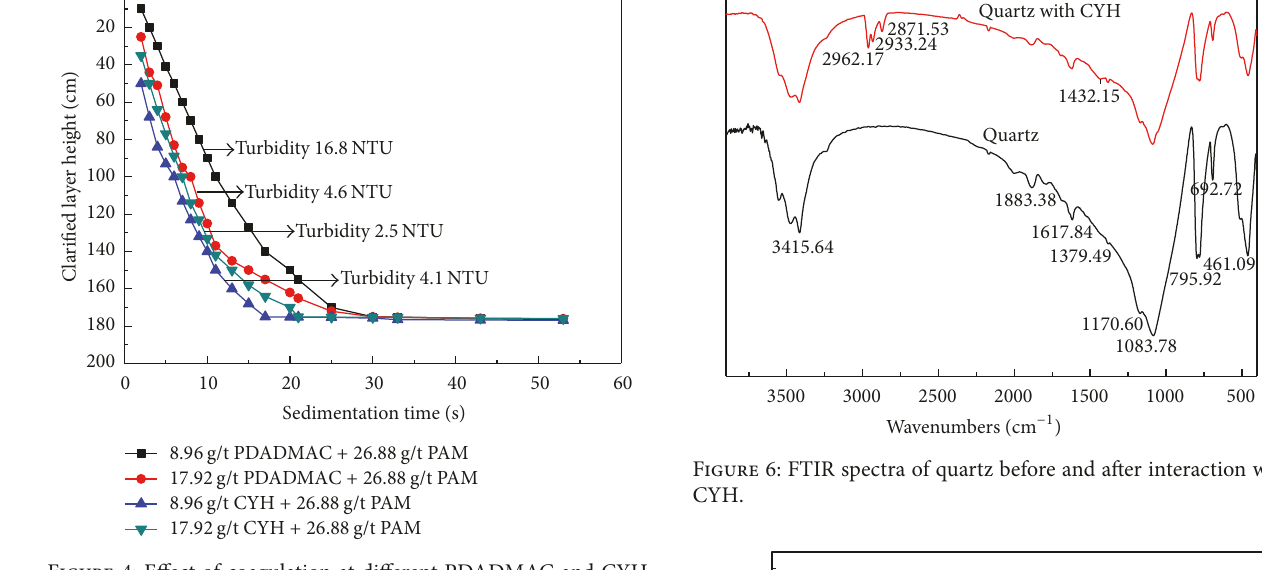
Figure 4: Effect of coagulation at different PDADMAC and CYH dosage.